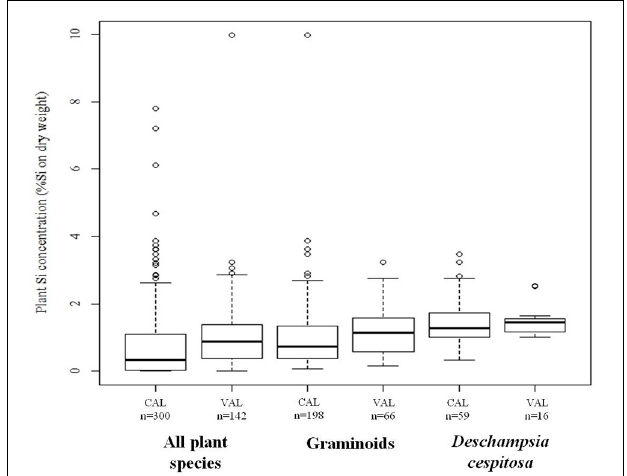
FIGURE 1 | Statistical summary (minimum, first quartile, median, third quartile, maximum value which is not an outlier, and outliers) of the plant silicon (Si) concentrations, measured by chemical analysis, in the calibration (CAL) and validation (VAL) dataset of the “all species” model, the “graminoids” model, and the “ Deschampsia cespitosa ”